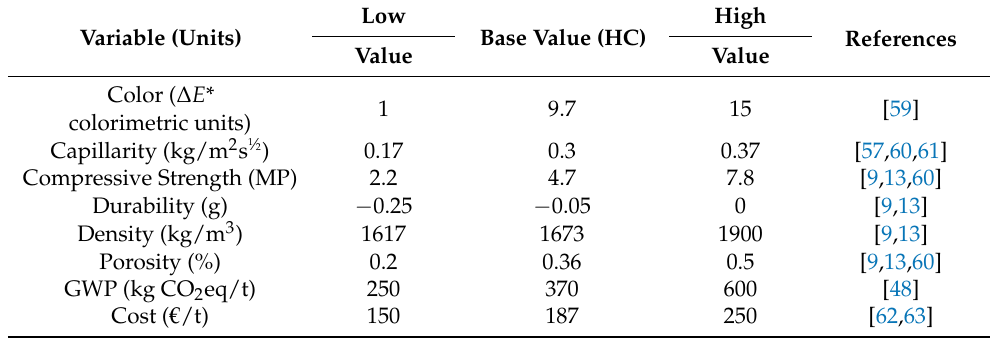
Table 4. Scenarios for the sensitivity analysis.